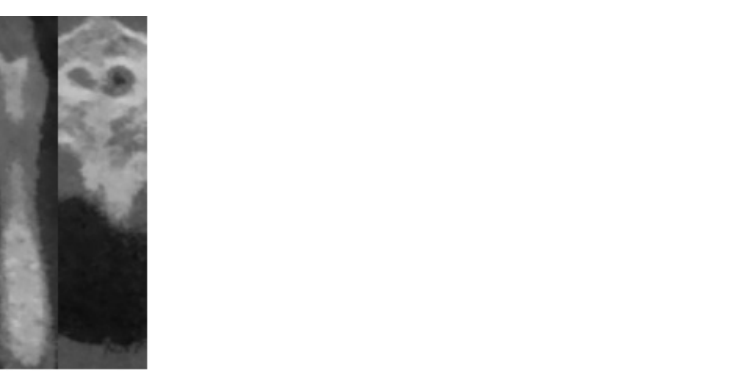
Figure 5. The image example of sagittal, coronal, and axial views of one CBCT file.